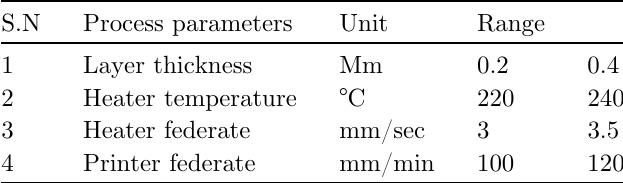
Table 2. Predictor variables and their setting ranges.